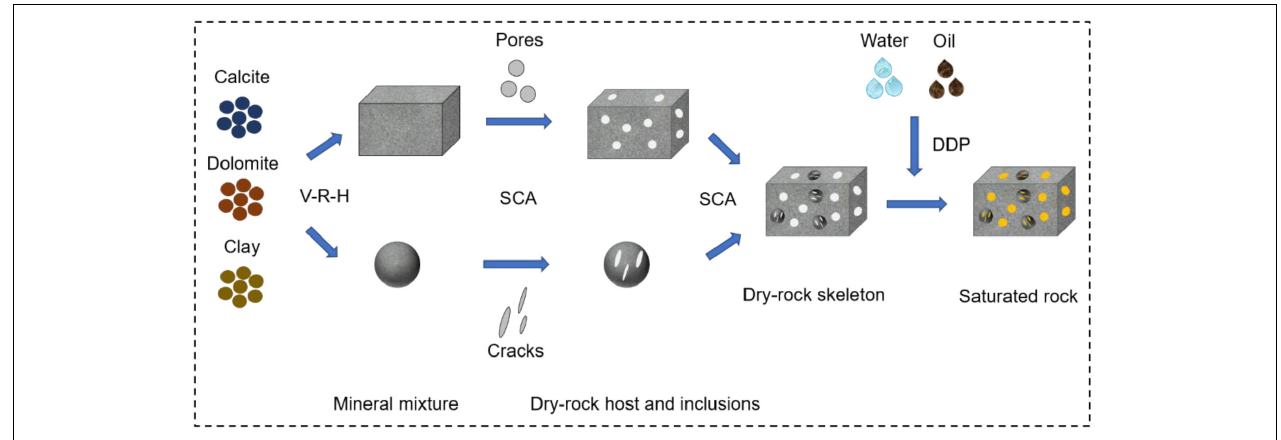
FIGURE 2 | Flowchart of the rock-physics modeling.